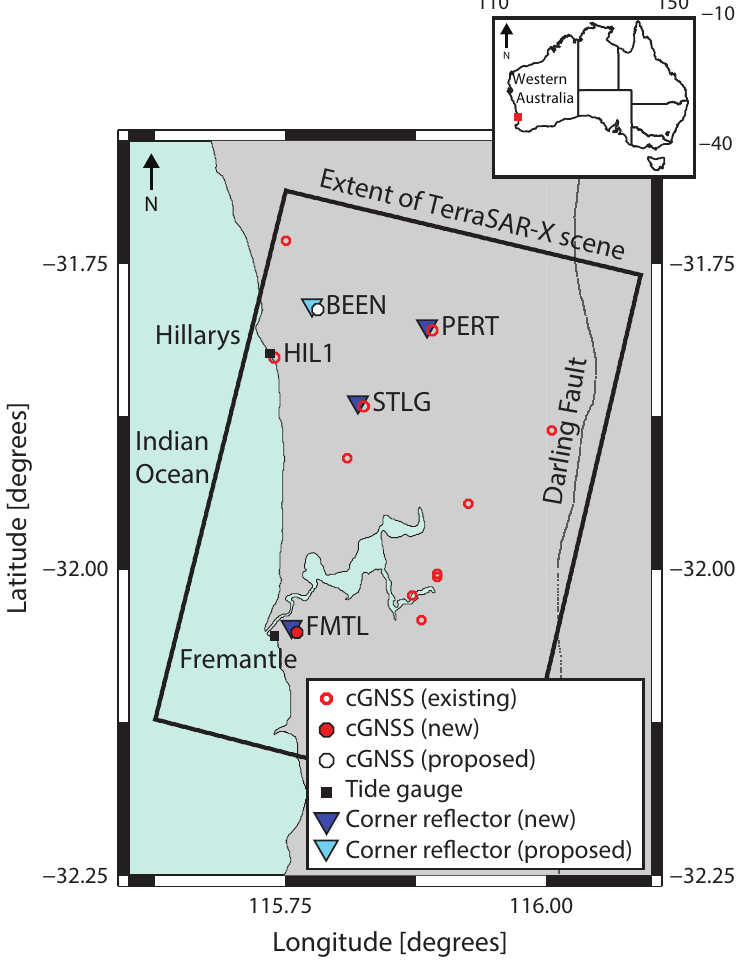
Figure 1. The distribution of ground-based geodetic infrastructure for measuring vertical land motion (VLM) in the Perth region, including: new, proposed and existing continuous GNSS (cGNSS); corner reflectors (new and proposed); and existing tide gauges. The rectangle shows the extent of TerraSAR-X InSAR scenes. The extent of the Sentinel-1B InSAR scenes covers the entire region. STLG—Stirling; PERT—Perth; FMTL—Fremantle; BEEN—Beenyup wastewater injection plant; HIL1—Hillarys. Inset: Map of Australia with the study region highlighted by the red